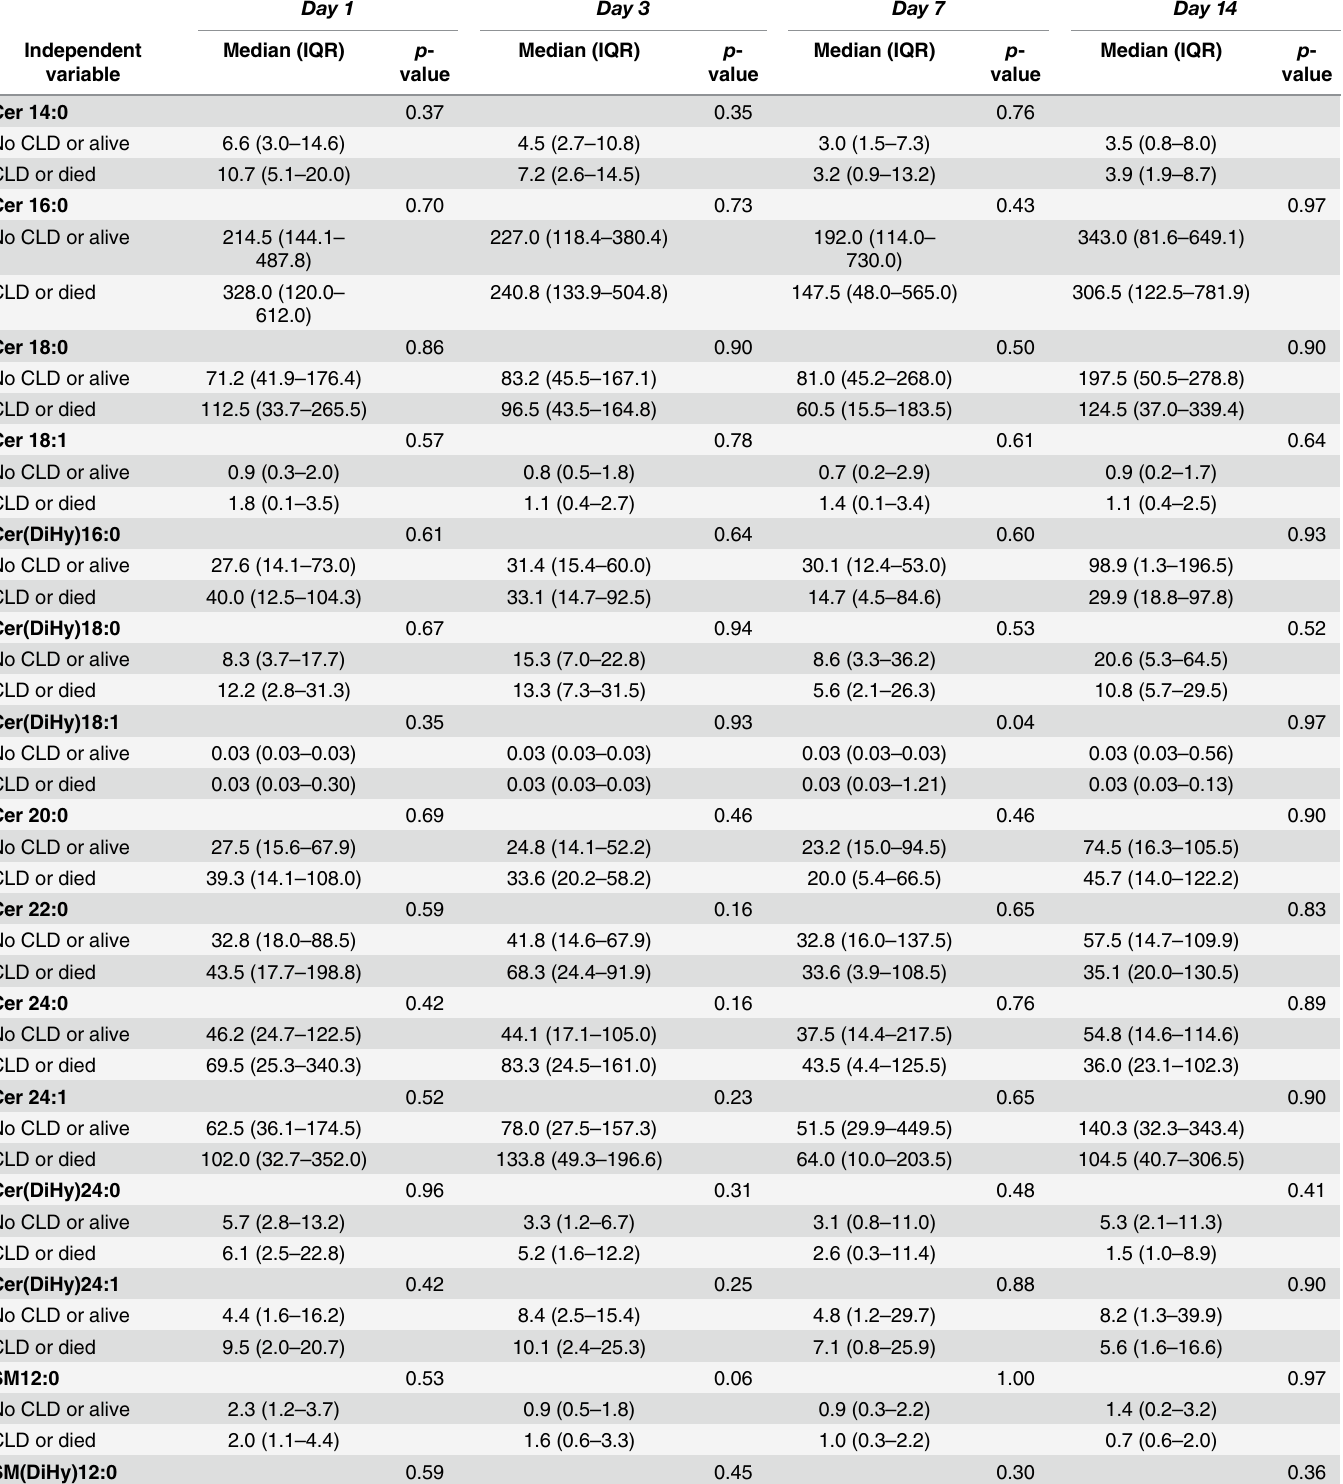
Table 2. Associations of sphingolipids with outcome mortality/ development of CLD. Day 1 Day 3 Day